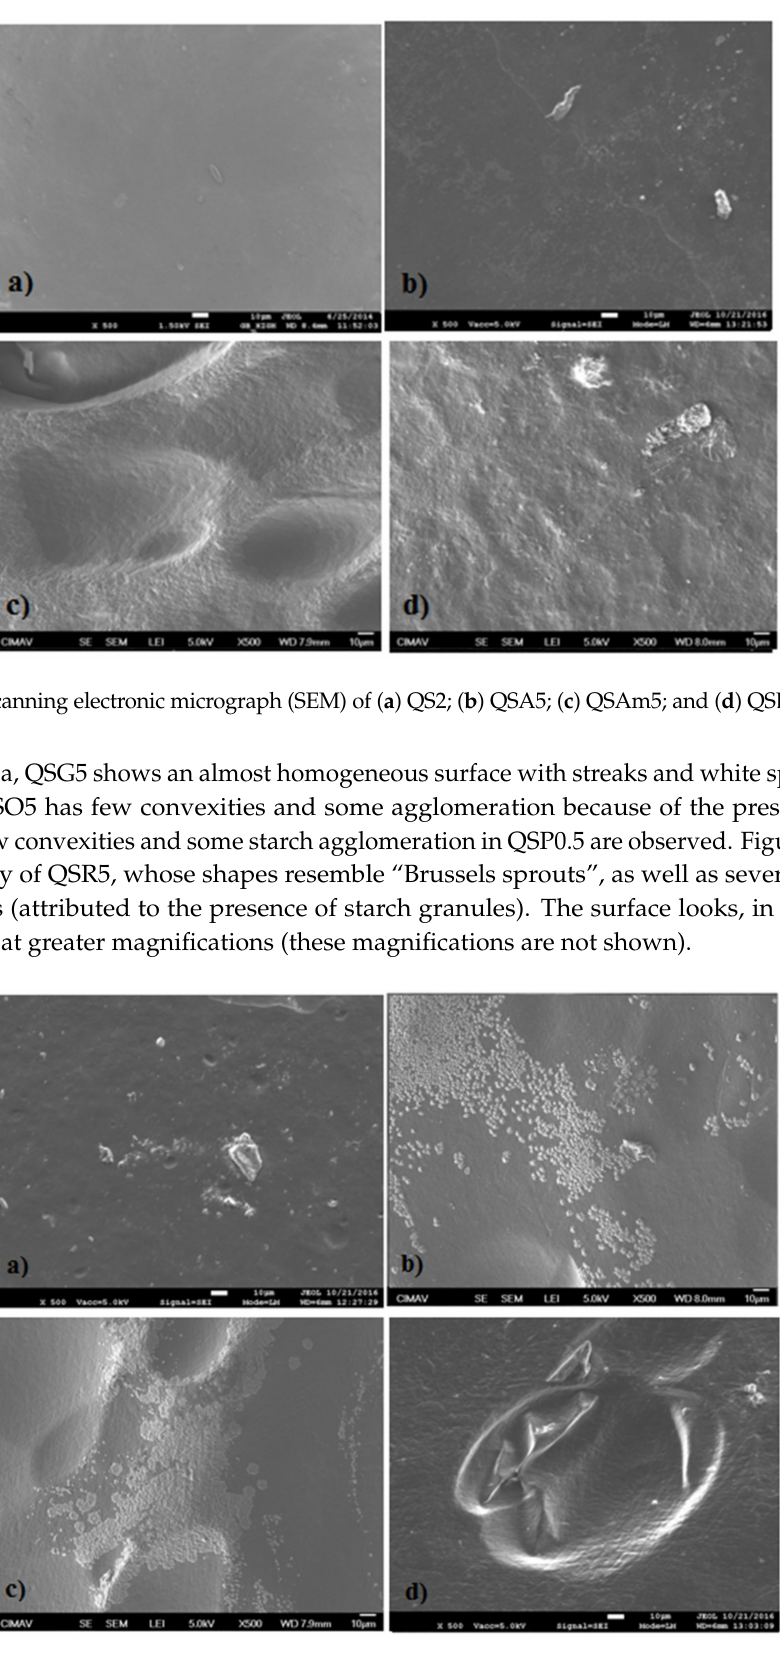
Figure 9. Scanning electronic micrograph (SEM) of ( a ) QSG5; ( b ) QSO5; ( c ) QSP0.5; and ( d ) QSR5 at 500 ×